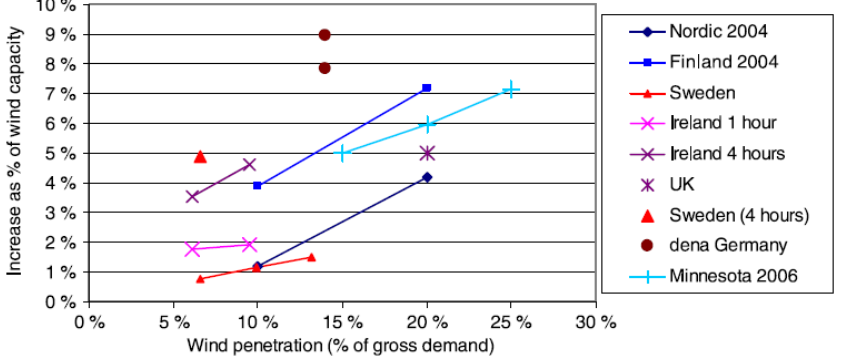
Figure 52. Increase in short-term balancing requirement as a percentage of wind power as a function of wind penetration (© 2008 IOP, reproduced with permission from